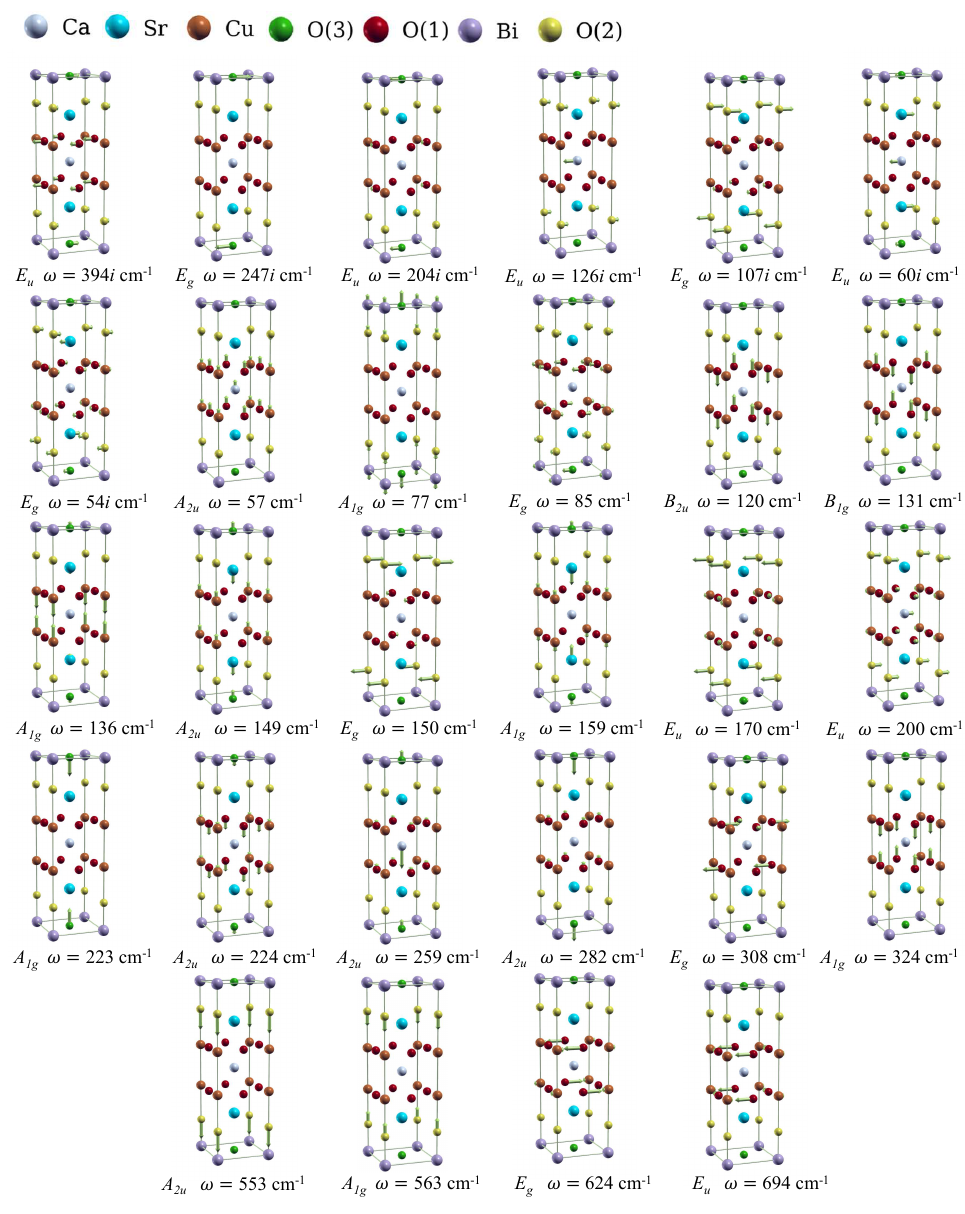
Figure A7: All optical Bi2212 modes at the Γ